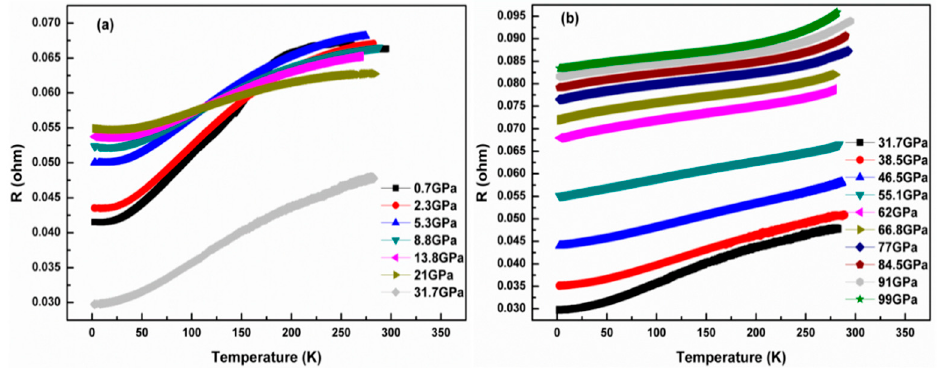
Figure 2. ( a ) Temperature dependence of ab -plane resistance at various pressures range from 0.7 to 31.7 GPa; ( b ) Temperature dependence of ab -plane resistance at various pressures range from 31.7 to 99 GPa.